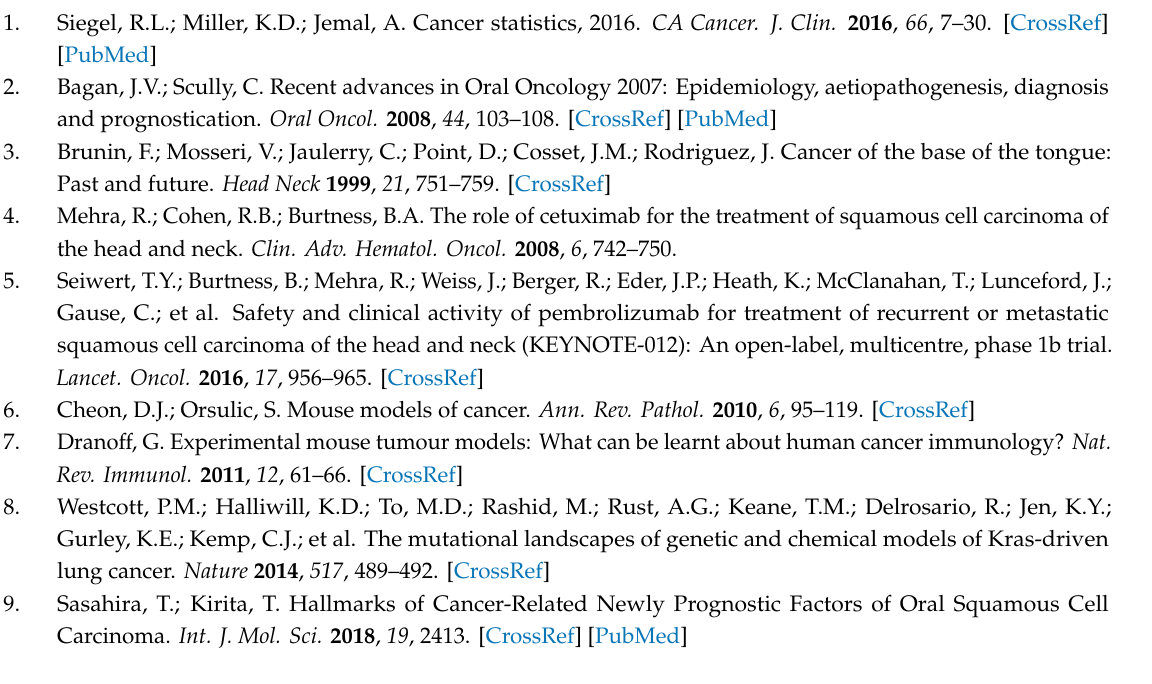
Table S1: Short tandem repeat (STR) genotyping of mouse cell lines, Figure S1: Establishment and genetic identification of mouse OSCC cells, Figure S2: Characterization of mouse OSCC cells, Figure S3: Tumor growth of mouse OSCC cells in nude mice and B6 mice, Figure S4: Gene expression analysis of 4 mouse OSCC cell lines and 40 pairs of OSCC and their corresponding adjacent nontumor tissues, Figure S5: ERK activation in NHRI-HN1 cells, Figure S6: Blockage of ERK activation by PD98059 inhibited cell migration and stemness of human OSCC cells. Figure S7: The uncropped scans of western blots from the main and supplementary